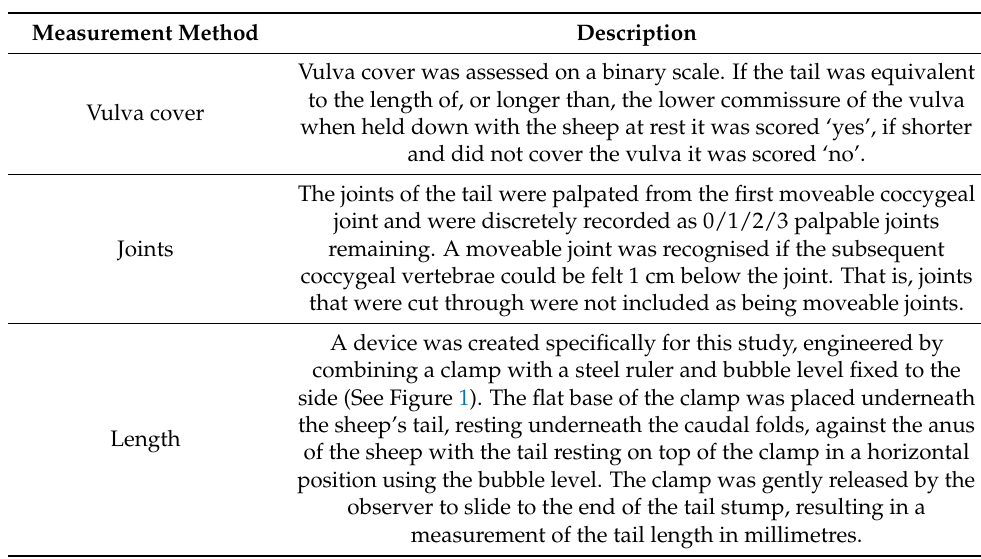
Table 1. Descriptions of the tail measurement methods